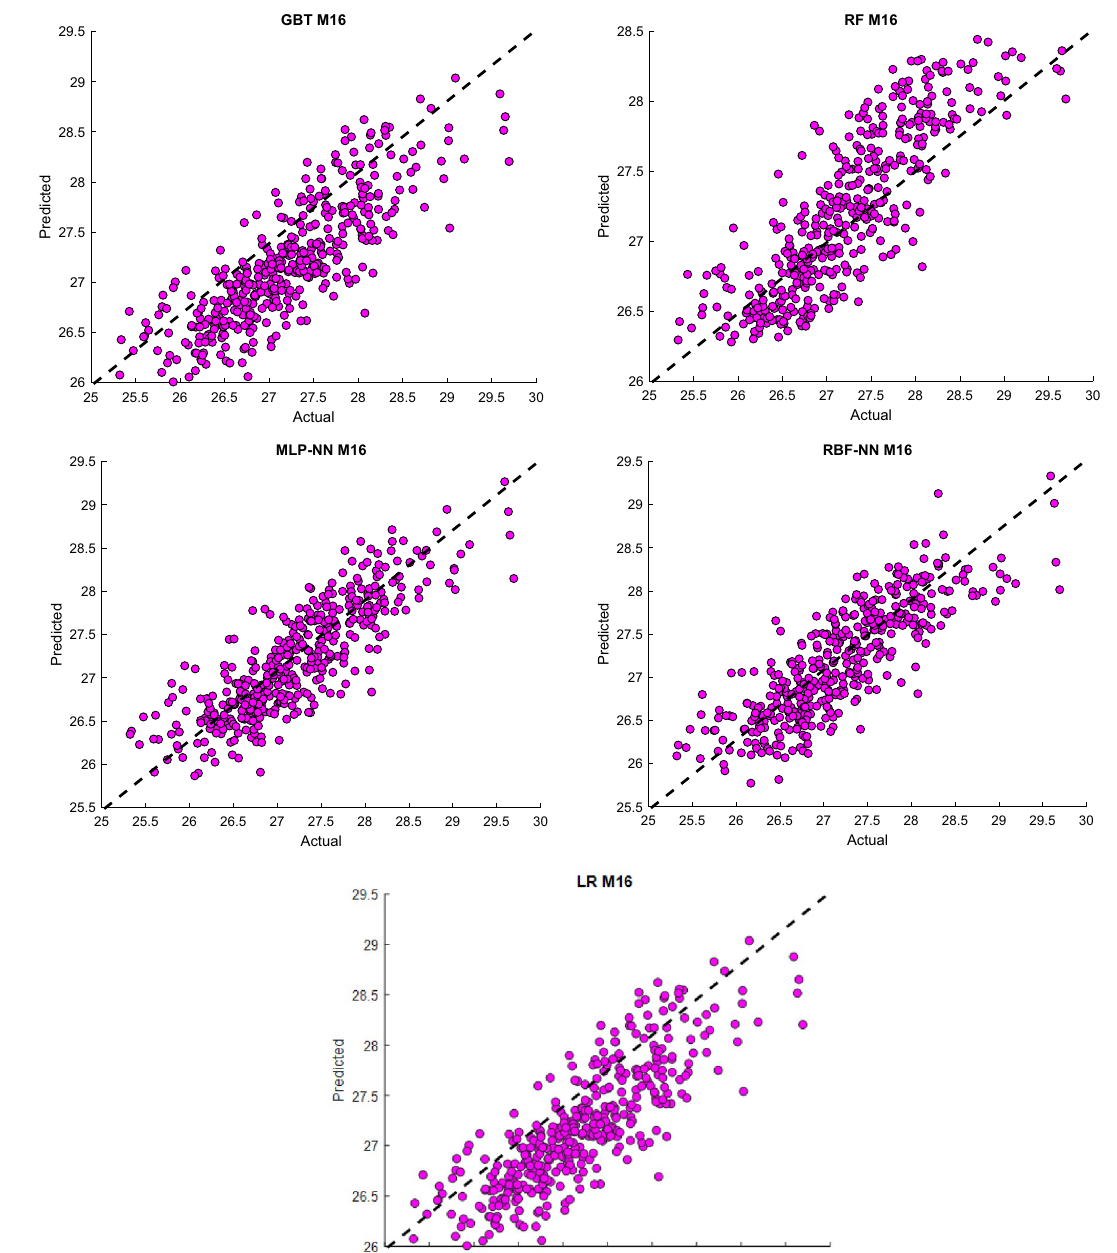
Figure 8. Observed and predicted monthly T values use the most accurate input combination using the developed ML